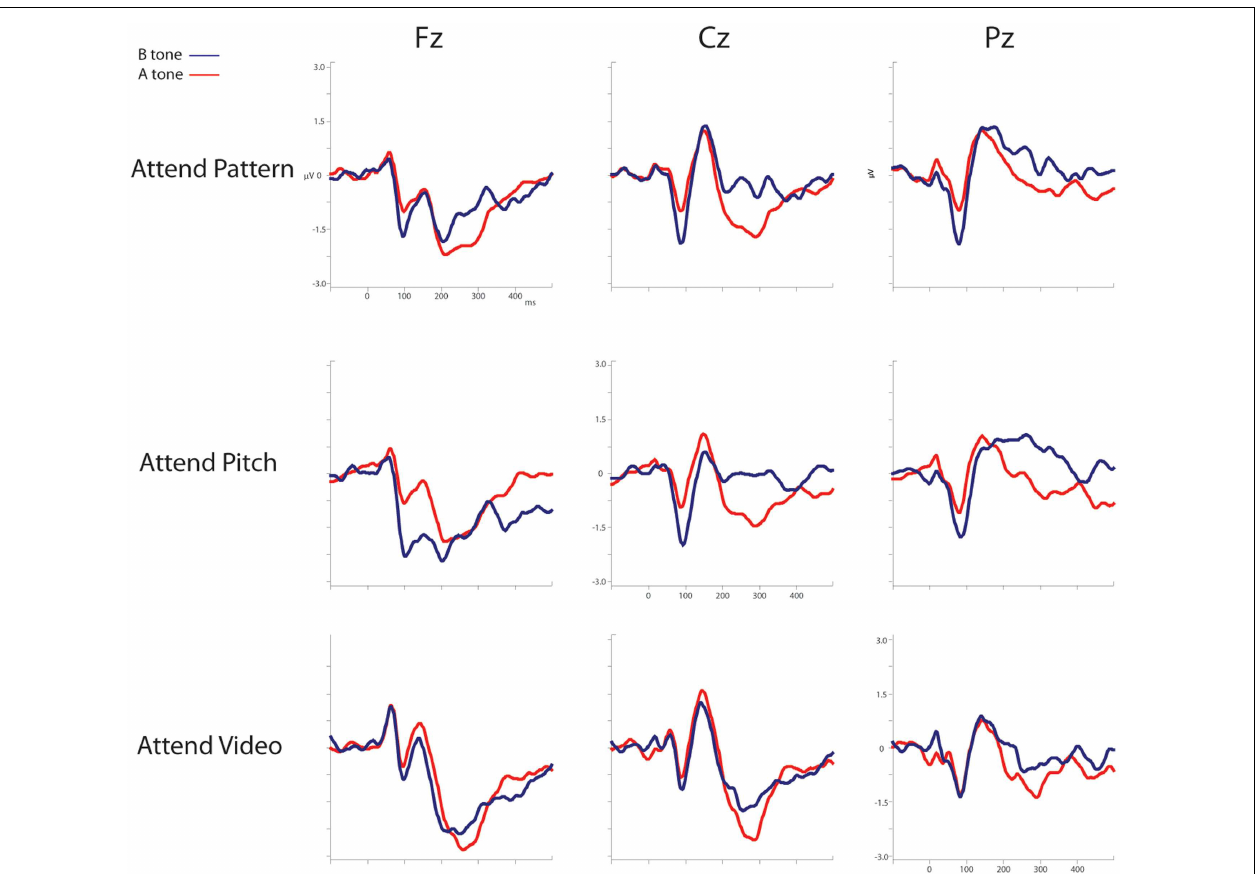
Attend-Video (bottom row) conditions. Midline electrodes are in columns (Fz, left; Cz, middle; and Pz, right). Ordinate is the amplitude in microvolts, and the abscissa shows the timeline in